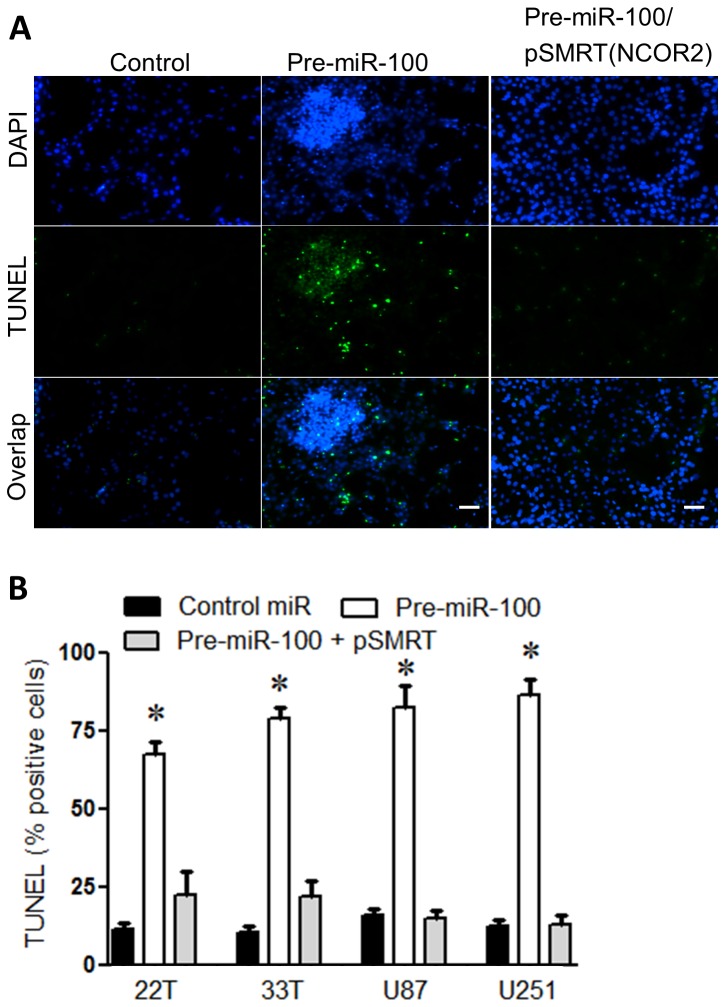
SMRT rescued tumor cells and avoids decreased cell death.(A) Treatment with both pre-miR-100 and SMRT/NCOR2 (pSMRT/NCOR2) overexpression prevented avoided induced cell death as shown by TUNEL staining compared to pre-miR-100 alone. The control cells were treated with control miR (ـــ) Scale bar, 50 um. (B) Quantitative analysis show marked decrease of TUNEL-positive cells in GBMs transfected with both SMRT/NCOR2 and pre-miR-100 similar to the level of control miR treated group.